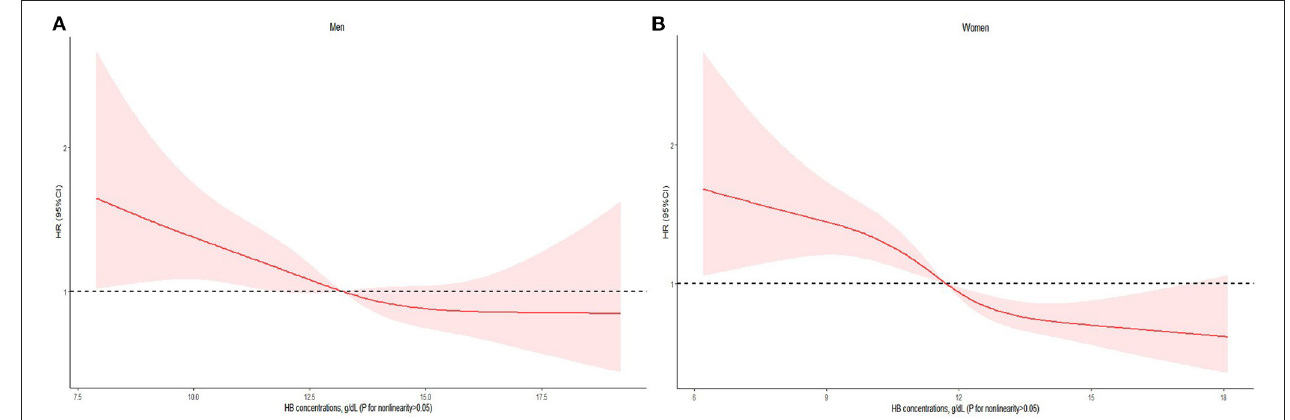
FIGURE 3 | HB on a continuous scale and risk of all-cause mortality in the older adults form Chinese longevity regions stratified by sex: (A) men, (B) women. Cox models with restricted cubic spline curves adjusted for age, education time, marital status, residence, economic status, smoking status, drinking status, tea drinking, food diversity score, regular exercise, ADL, self-reported diagnosed hypertension, diabetes, stroke, heart disease, MMSE score, depressive symptom score, BMI, CRP, eGFR, WBC count, MCV, platelet count, and TC.